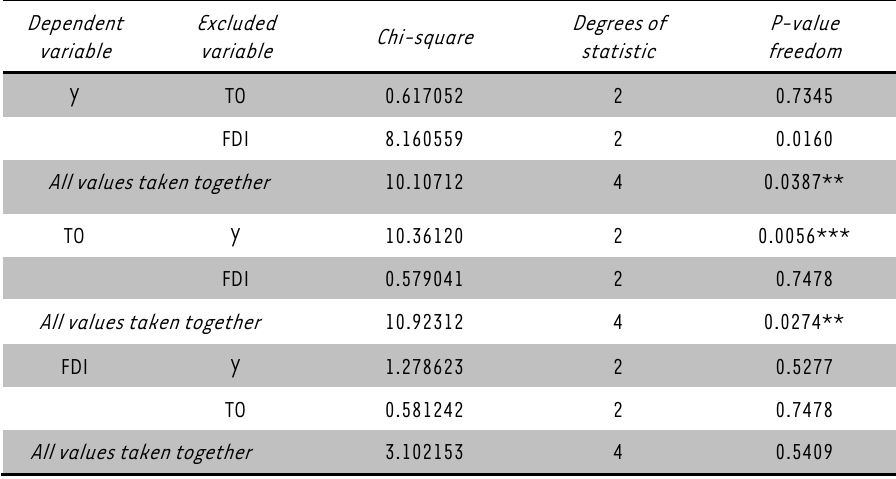
TABLE 3: VAR Granger Causality / Block Exogeneity Wald Test